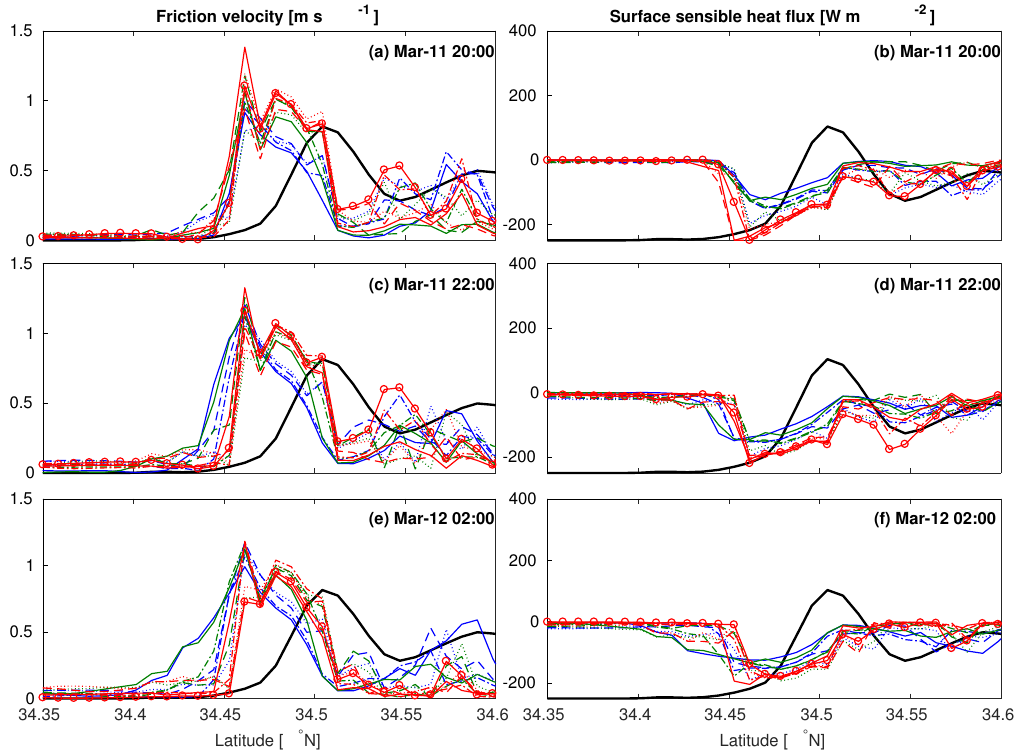
Figure 10. Same as Figure 7 but for ( a , c , e ) friction velocity and ( b , d , f ) surface sensible heat flux. Note that the times and axis differ from Figure